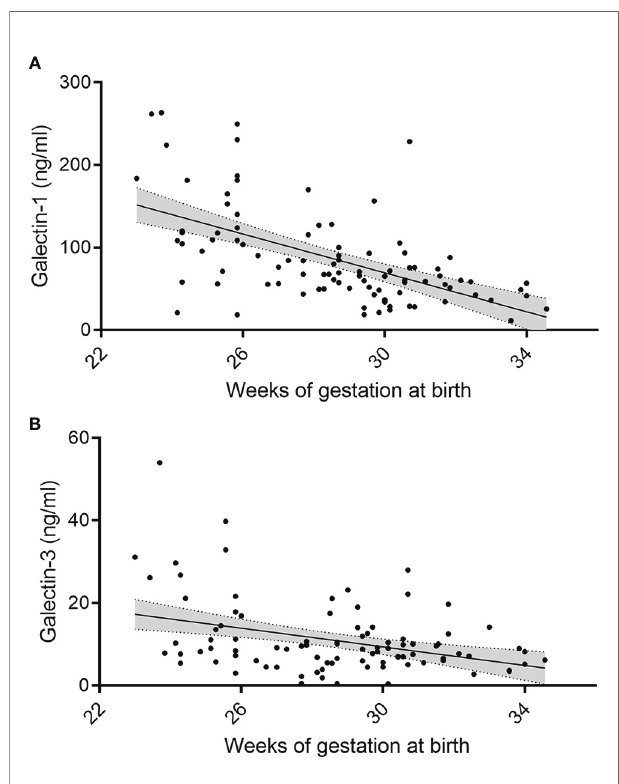
FIGURE 1 | Change in serum gal-1 and gal-3 levels in relation to postnatal and gestational age. (A, B) Levels of gal-1 (ng/ml) (A) and gal-3 (ng/ml) (B) at day 1 correlated to gestational age (in weeks, P < 0.05 , N = 96) as annalyzed by Mann-Whiteney U-test,